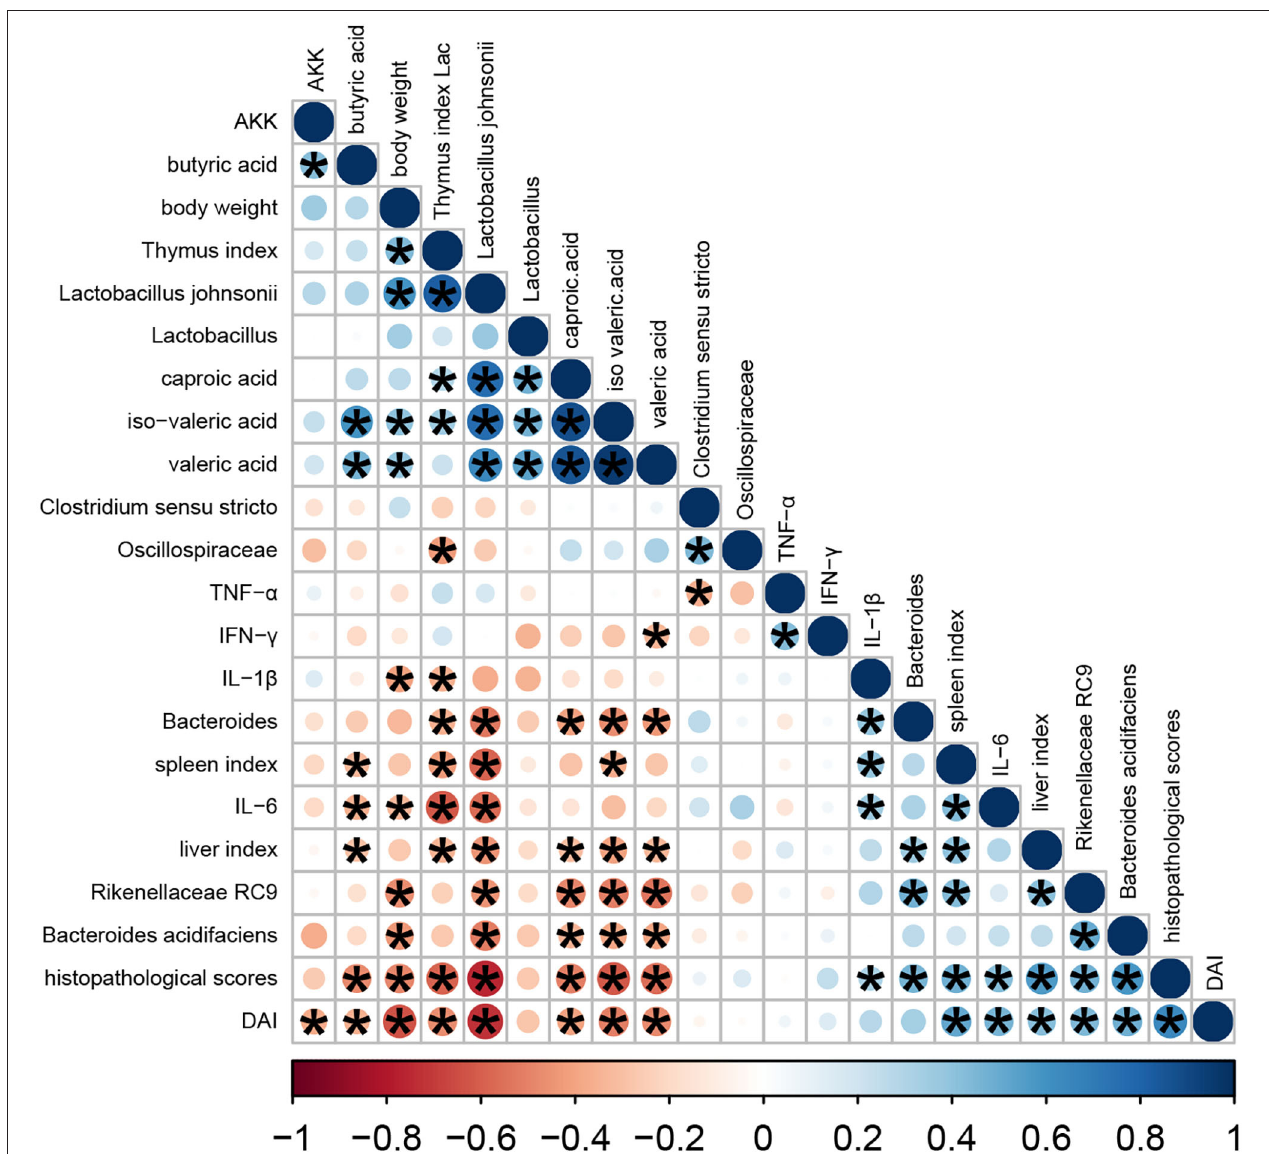
FIGURE 7 | Heatmap of Pearson correlation analysis. The color scale bar ranged from − 1.0 (red) to 1.0 (blue). The size and color of the circles indicate the magnitude of the correlation between parameters. Red and blue, respectively, denote negative and positive correlations. These were done in R.